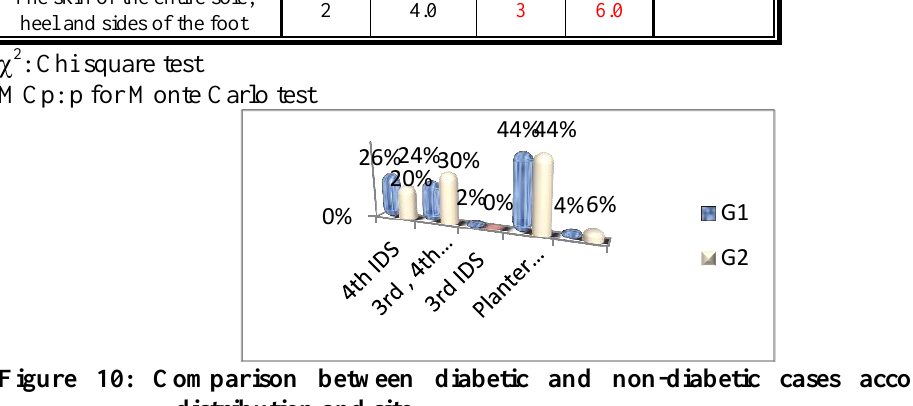
Figure 10: Comparison between diabetic and non-diabetic cases according to distribution and